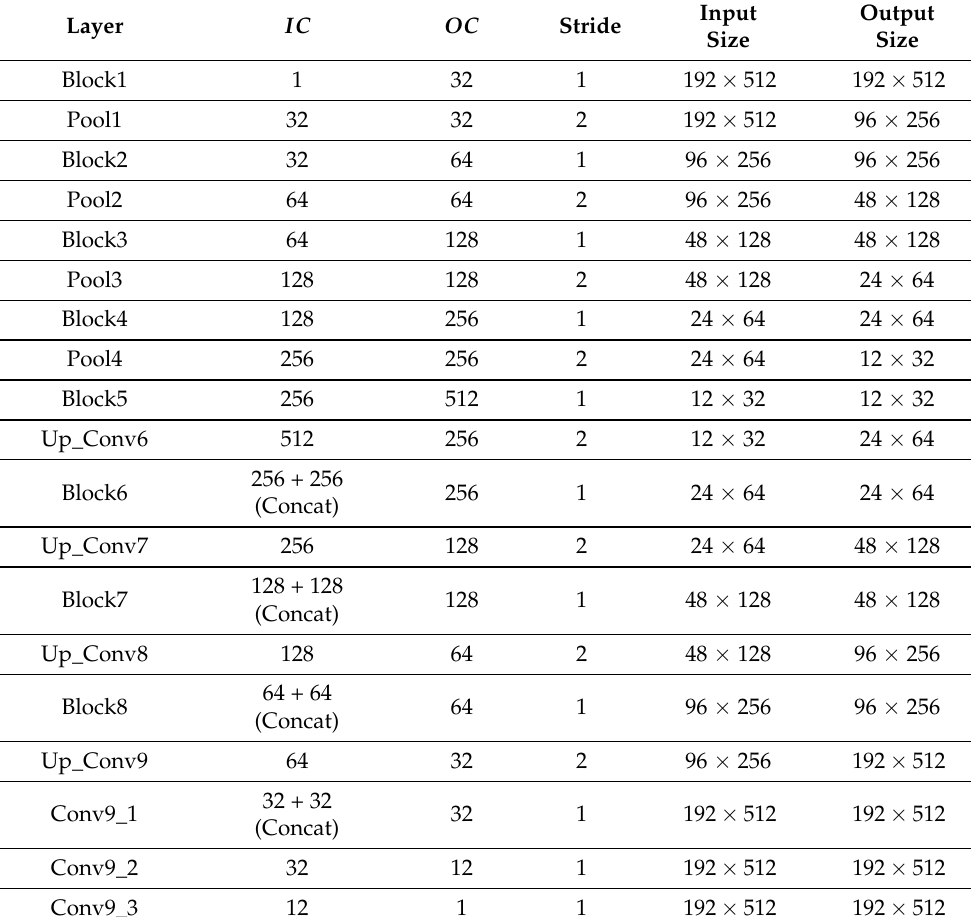
Table 1. Parametric Structure of the